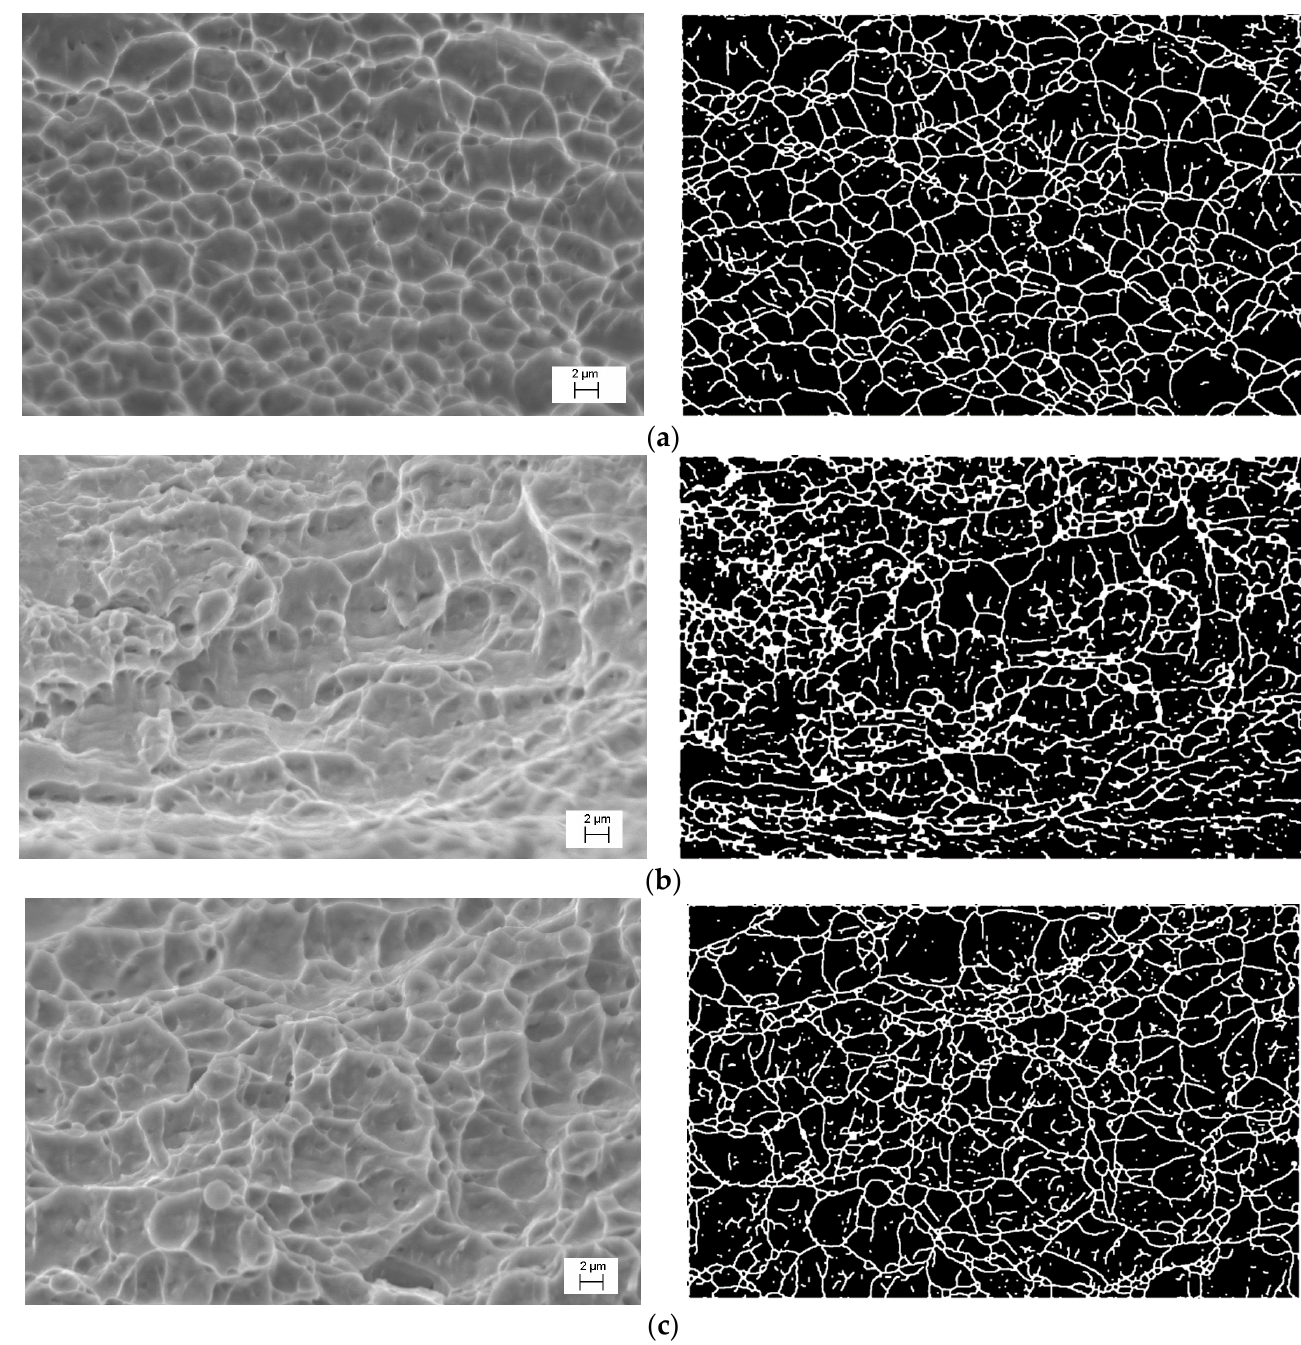
Figure 6. Fractograms of fracture surfaces of specimens made of the VT23 alloy rolled in the transverse direction, and their binarized mappings obtained after the impulse energy introduction under impact-oscillatory loading followed by static tensioning: ( a )— ε і mp = 0.81%; ( b )— ε і mp = 2.56%; ( c )— ε і mp = 4.56%.